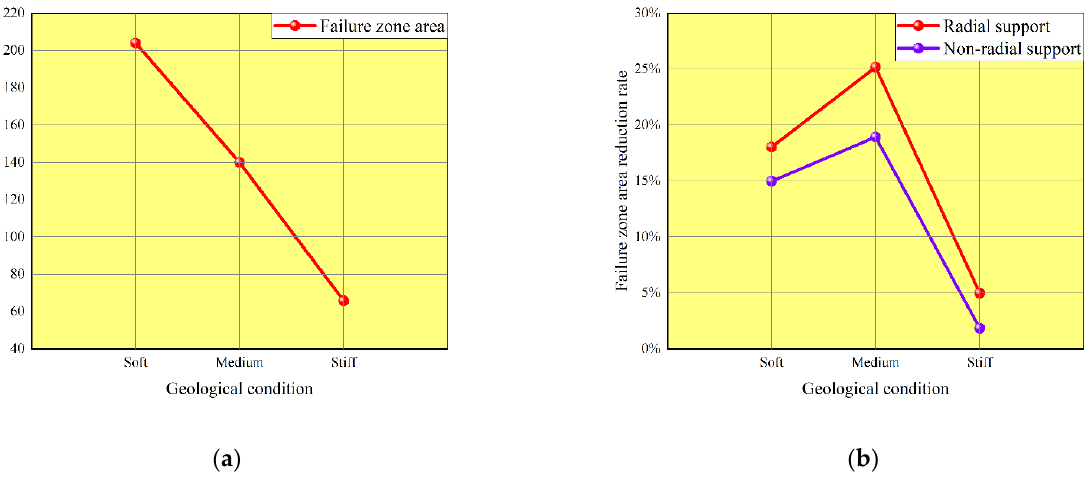
Figure 19. Displacement and variations of the support face under the two support schemes: ( a ) un- supported displacement, ( b ) roof displacement variations, and ( c ) lateral displacement variations.